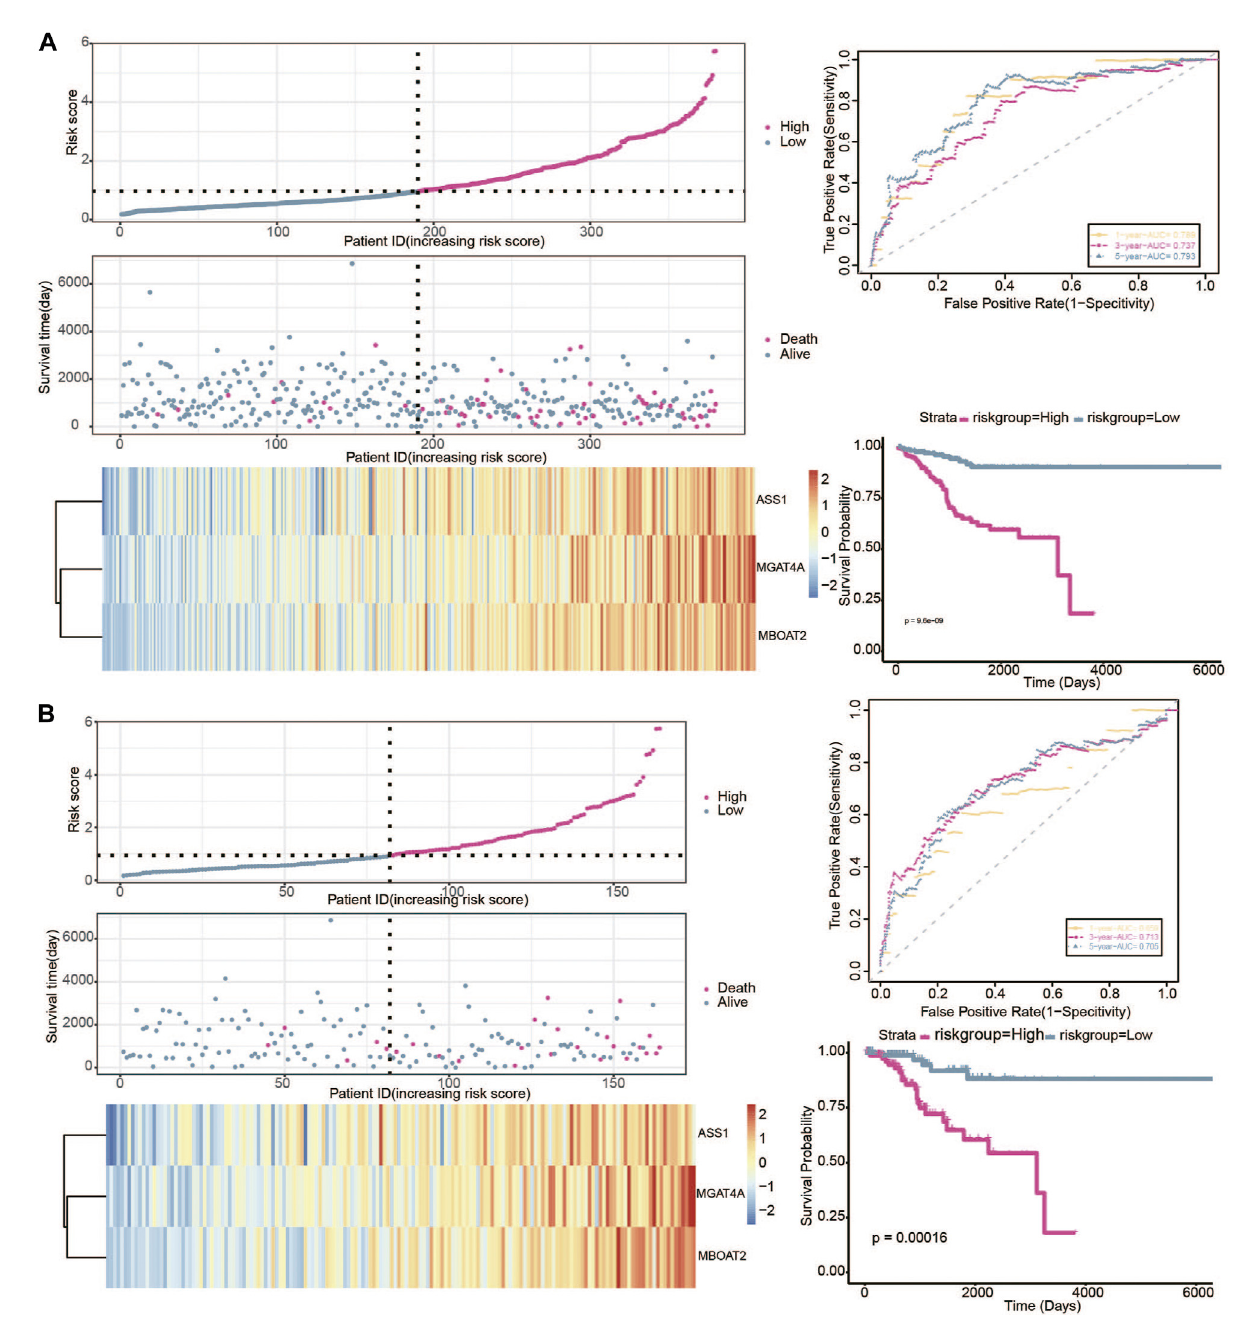
FIGURE 8 Veri fi cationofthepredictivevalueofgenesignatureinthe2validationdatasets. (A) Riskplot,ROCcurve,andKMcurveofhigh-riskandlow-riskgroupsin the validation1 set. (B) Risk plot, ROC curve, and KM curve of high-risk and low-risk groups in the validation2